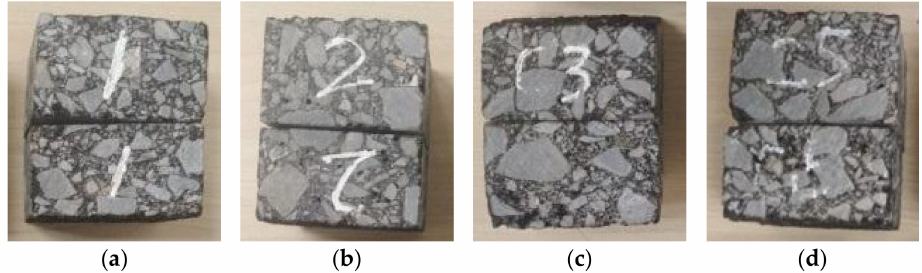
Figure 2. Specimens for the thermal conductivity and volume-specific heat capacity tests: ( a ) common asphalt mixture, ( b ) MFPCM-modified asphalt mixture, ( c ) CGMFPCM2-modified asphalt mixture, and ( d ) CGMFPCM3-modified asphalt mixture.